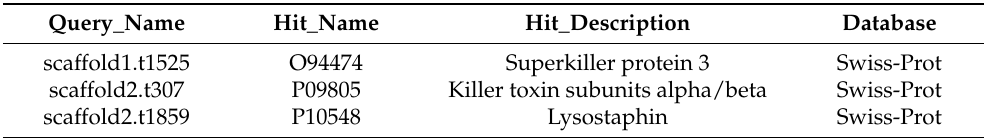
Table 4. Killer toxin and lysostaphin gene in S. bacillaris CC-PT4 genome.